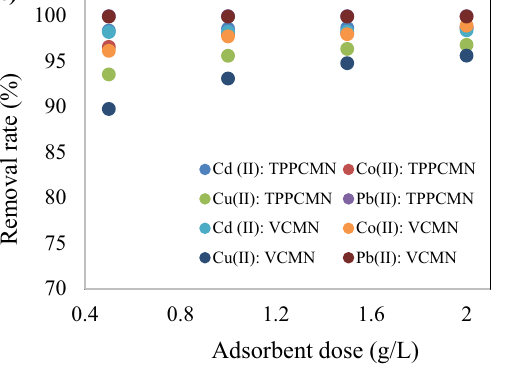
Figure 6. Effect of different operating conditions for the adsorption of Cd (II), Co (II), Cu (II) and Pb (II) ions from aqueous solutions using TPPCMN and VCMN nano-sorbents: ( a ) Initial solution pH, ( b ) Contact time, ( c ) Metal ion concentrations and ( d , e ) Adsorbent